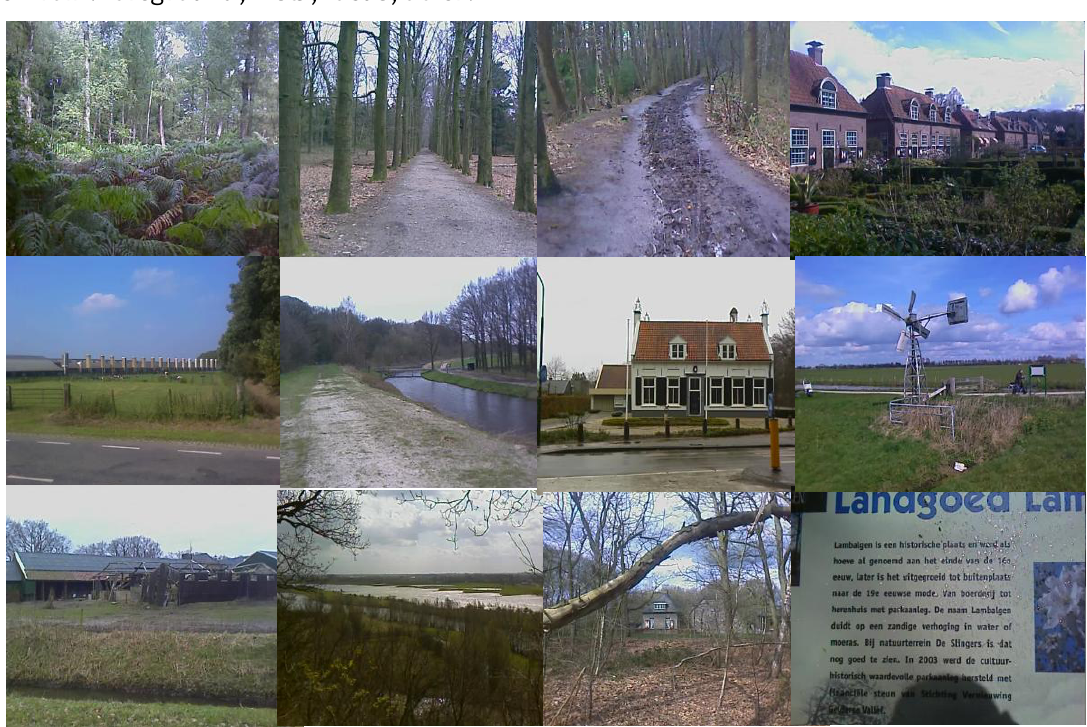
Figure 5. Examples of PP pictures made by test persons. Left to right in the 1 st row: vista, view line, foreground, focus; 2 nd row: focus, view line, foreground, focus; 3 rd row: foreground, vista, focus,